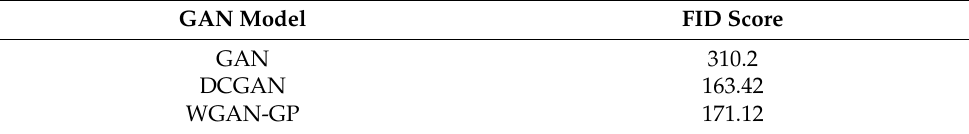
Table 2. Fréchet Inception Distance Scores of each